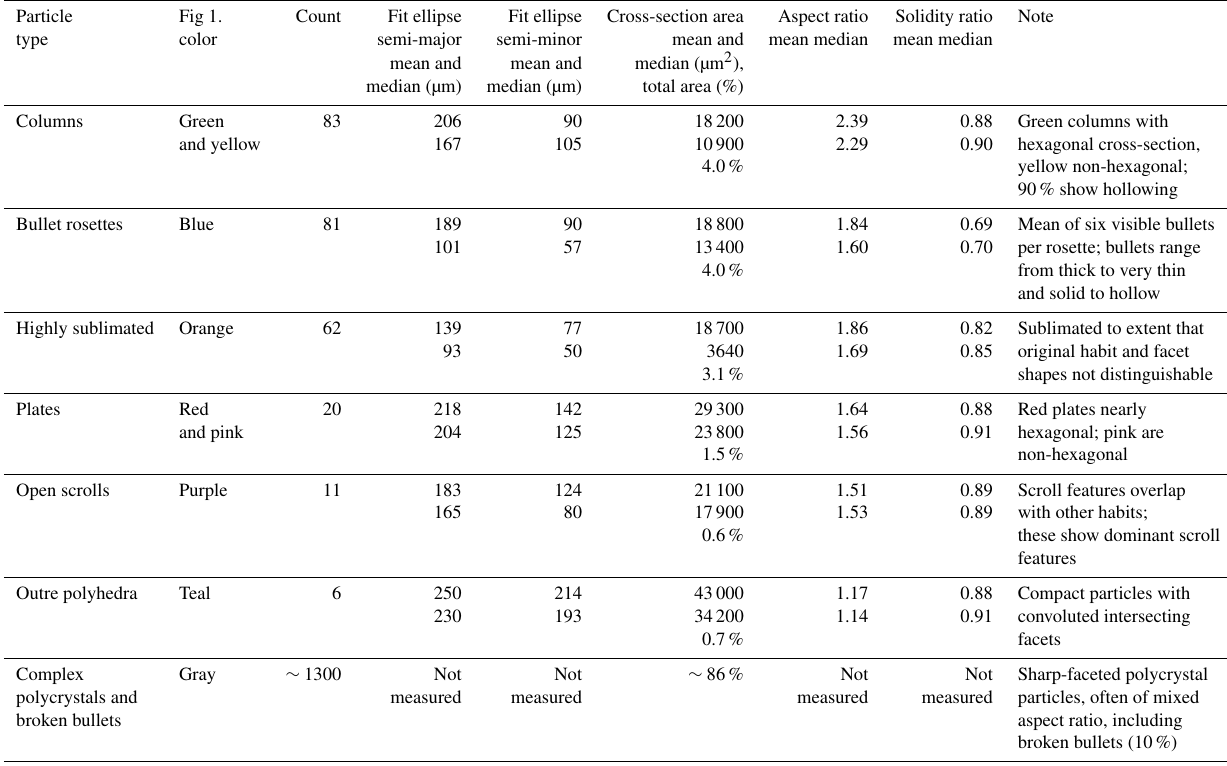
Table 1. Statistics for particle habit categories in Fig. 2. Particle Fig 1. Count Fit ellipse Fit ellipse Cross-section area Aspect ratio Solidity ratio Note type semi-major semi-minor mean and mean median mean median mean